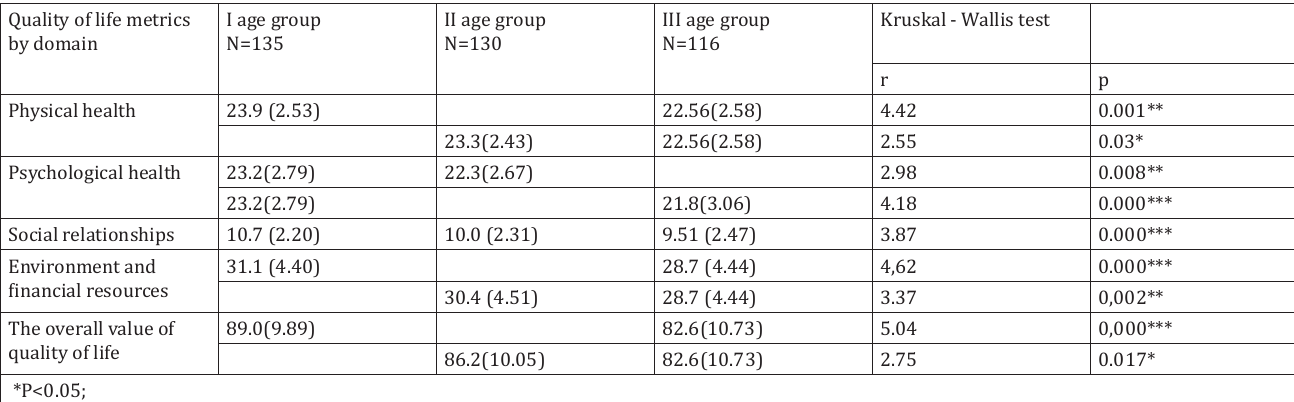
Indicators of quality of life by age